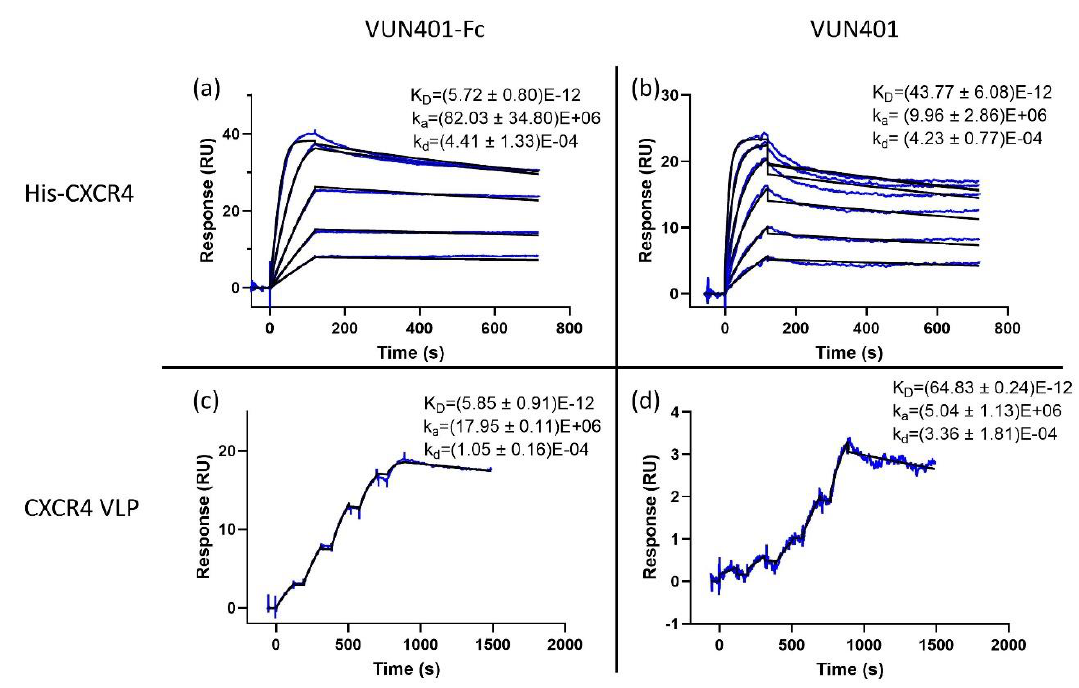
Figure 4. ( a ) VUN401-Fc bivalent Nb (concentration range of 1.25–0.08 nM using a two-fold